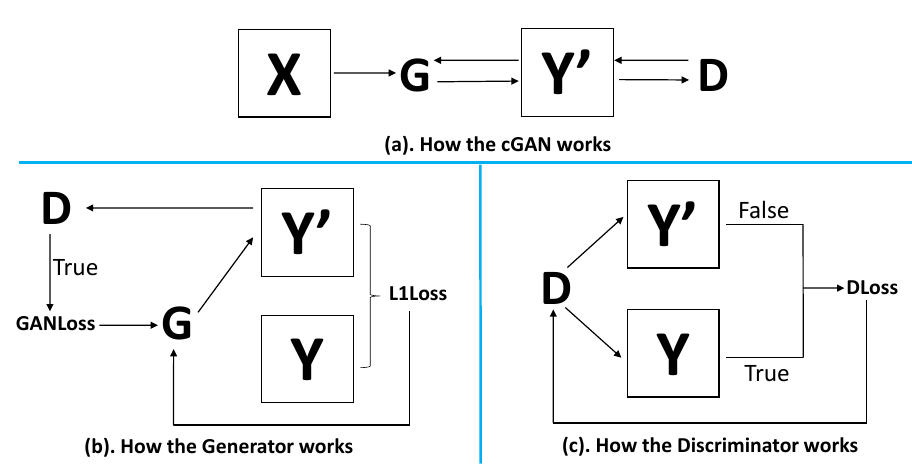
Figure 5. The flowchart of the cGAN (D: Discriminator; G: Generator)